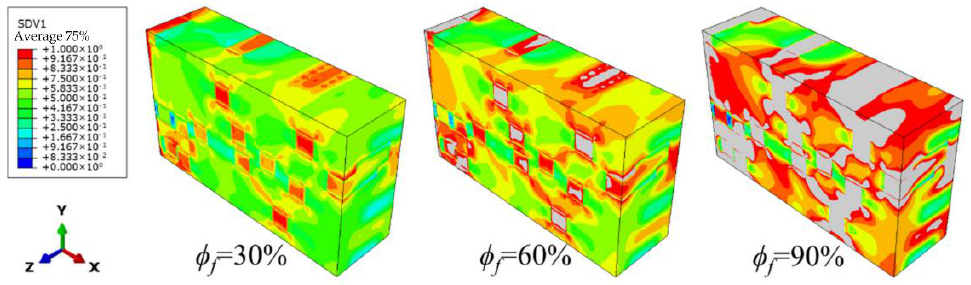
Figure 9. Damage evolution process in macroscopic model of 3D needled composites.